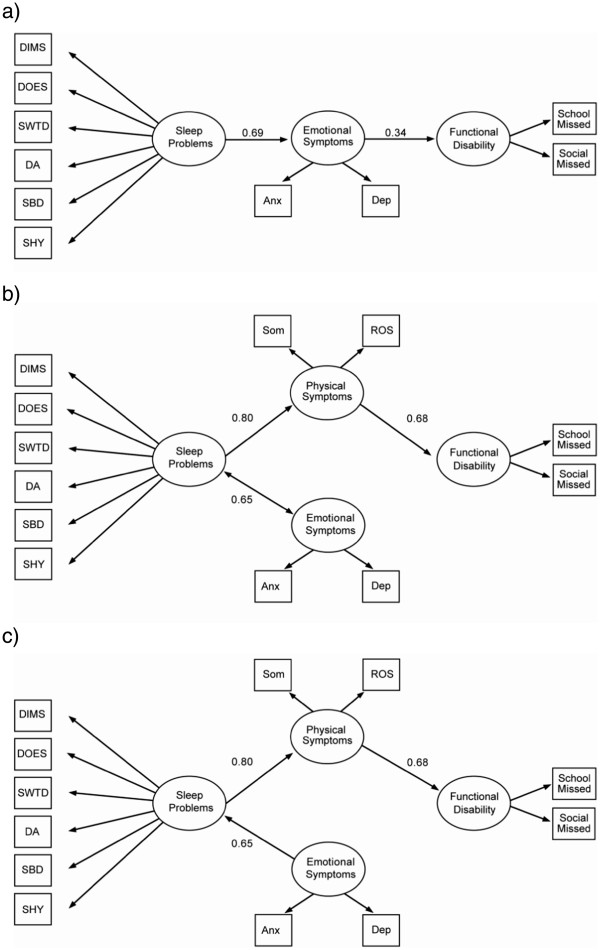
Three extended causal models to further assess associations between sleep problems and emotional symptoms. Extended causal models: a. M3.1. Pruned emotional symptoms causal model (χ2, p<0.01, poor model fit). b. M3.2. Emotional symptoms and sleep problems correlational model (χ2, p=0.29, good model fit). c. M3.3. Emotional symptoms to sleep problems causal model (χ2, p=0.29, good model fit). Note. Paths with significant partial regression coefficient or correlation coefficient (p<0.05) represented by solid lines; non-significant paths represented by dashed lines.